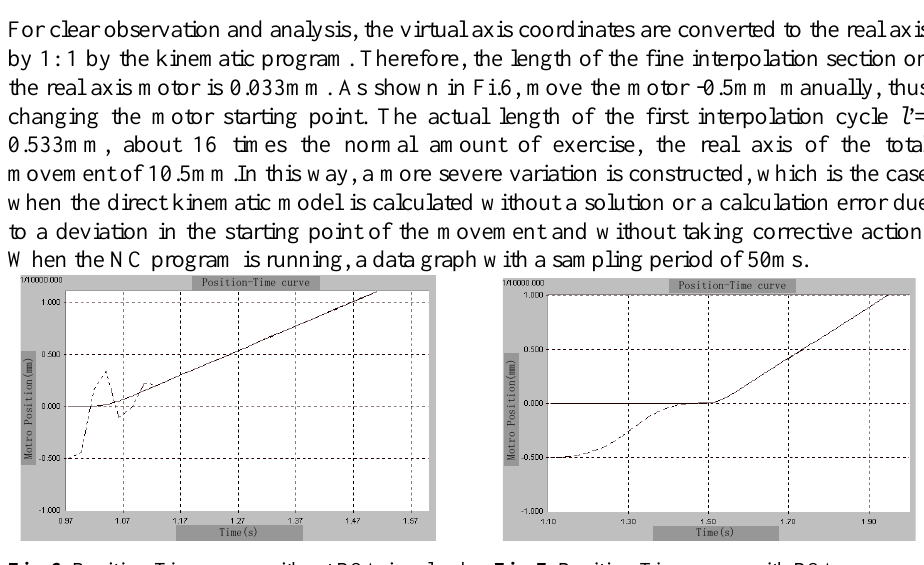
Fig. 6. Position-Time curve without PCA involved. Fig. 7. Position-Time curve with